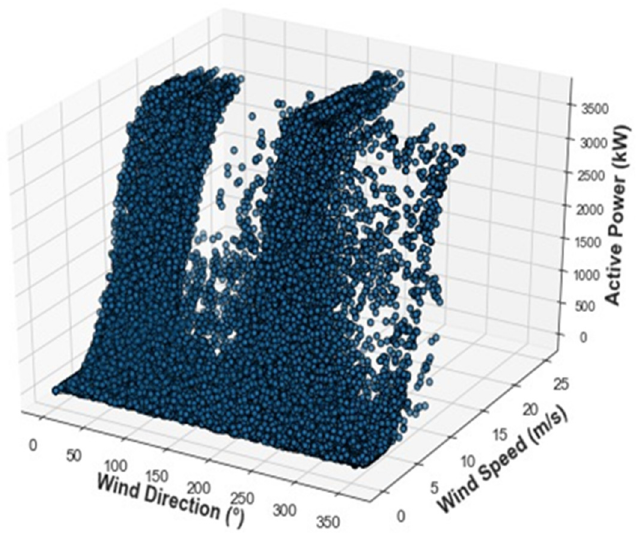
Figure 8. Relationship between wind speed, wind direction, and power generation in a 3D visuali- zation.